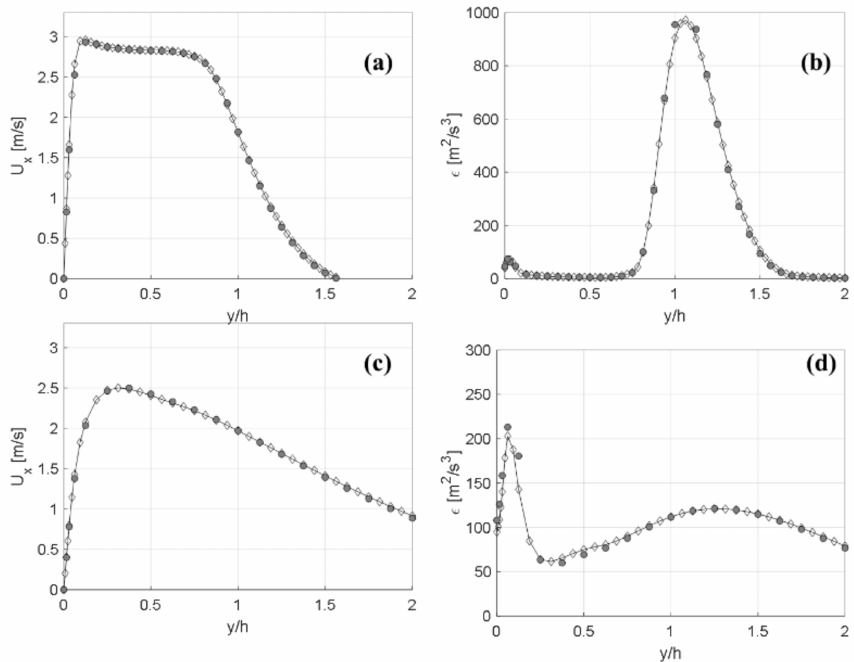
Figure 3. Mesh resolution validation. ( a , c ): Stream-wise average velocity, U x, and ( b , d ): dissipation rate of TKE, ε , on two lines perpendicular to the lower wall ( x/h = 1 in ( a , b ) and at x/h = 10 in ( c , d )). Grey markers show the mesh used in the study, the white markers show the denser mesh used in the mesh-validation stage